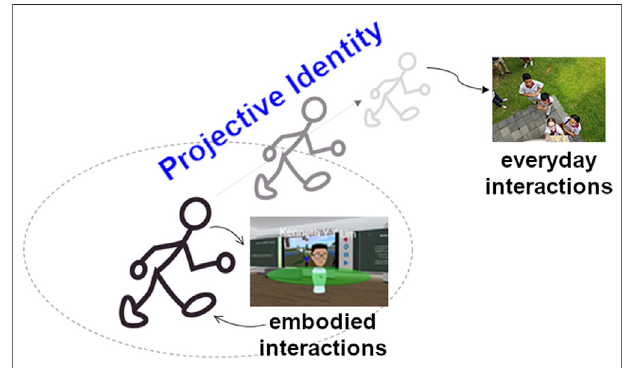
FIGURE2 | The SORBET approach, embodied cognition and projective identity, and the intuition of novices.